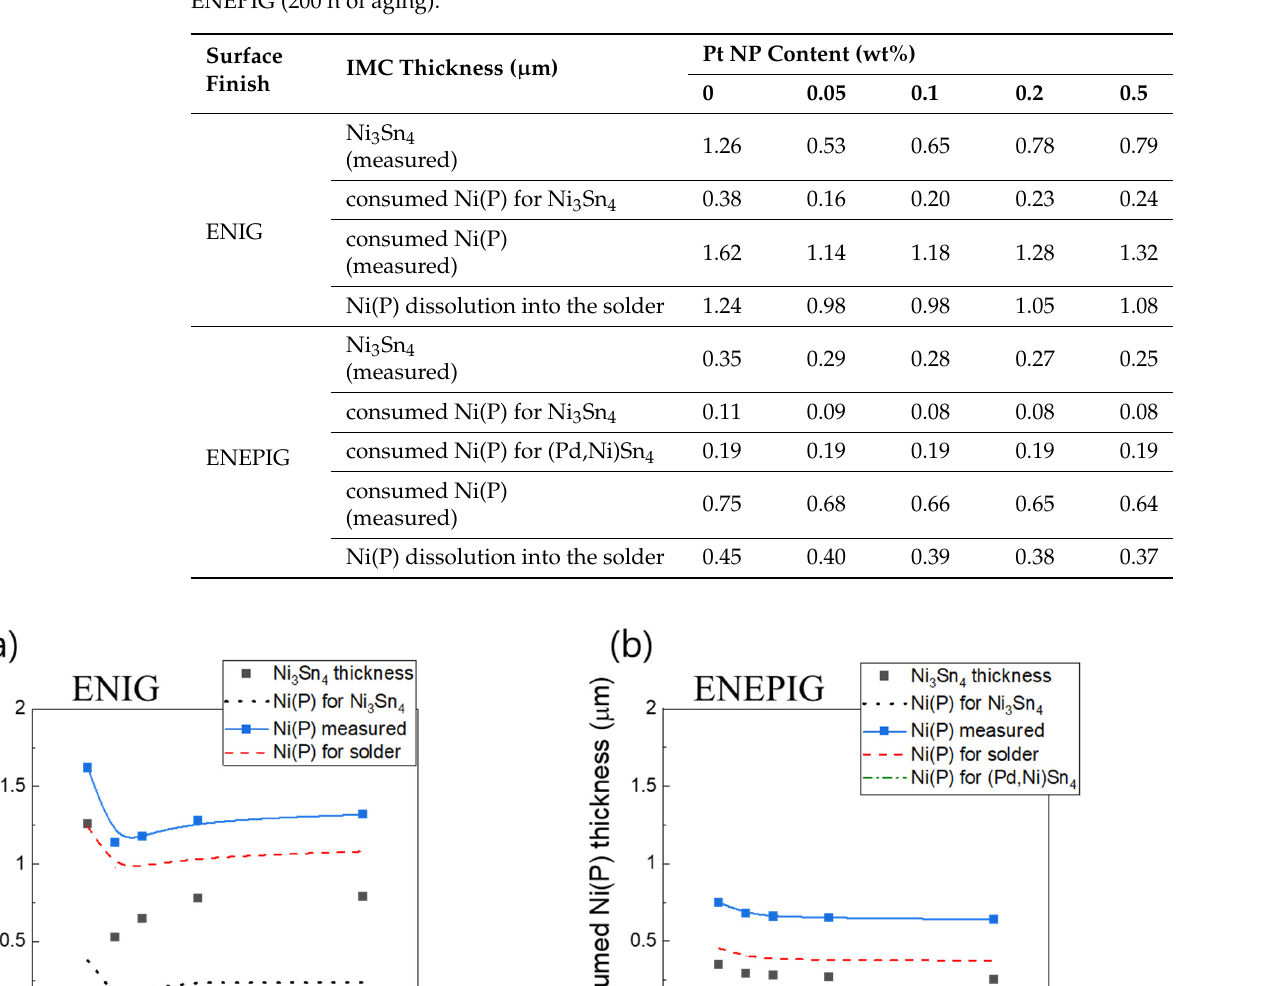
Table 1. Consumed thickness of the Ni-P layer for the formation of interfacial IMCs on the ENIG and ENEPIG (200 h of aging).